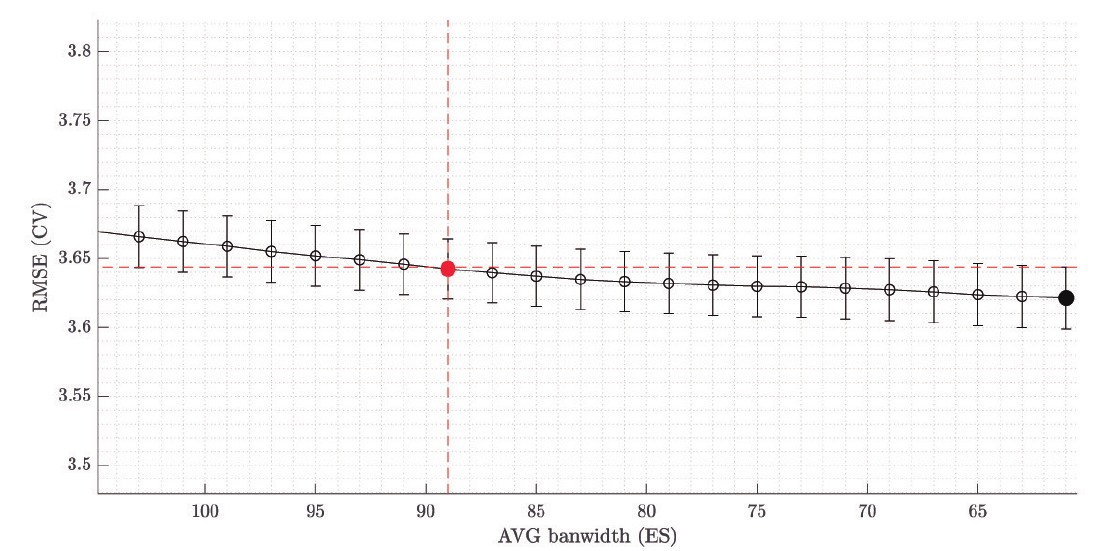
Figure 5. Detail of the error curve with error bars obtained by repeated cross-validation at each point, for the method AVG, and the maximum temperature of Spain. The smoothest model (banwidth = 89) whose error is inside the 95% confidence interval of the best one (banwidth = 61) is chosen, indicated by the red vertical broken